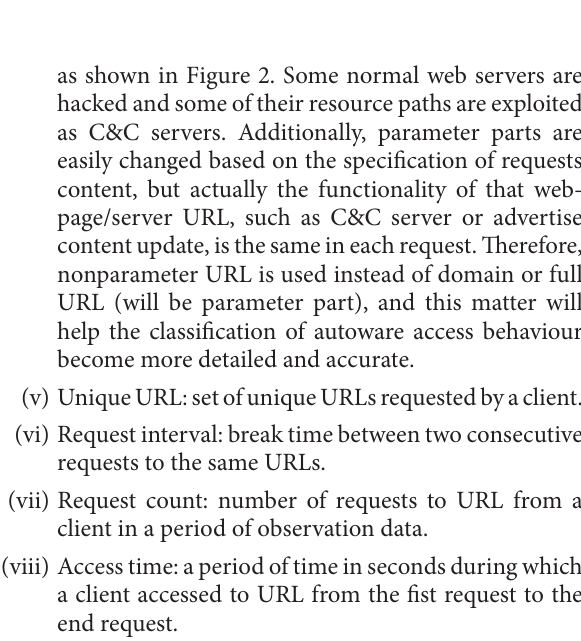
Figure 2: Main parts of